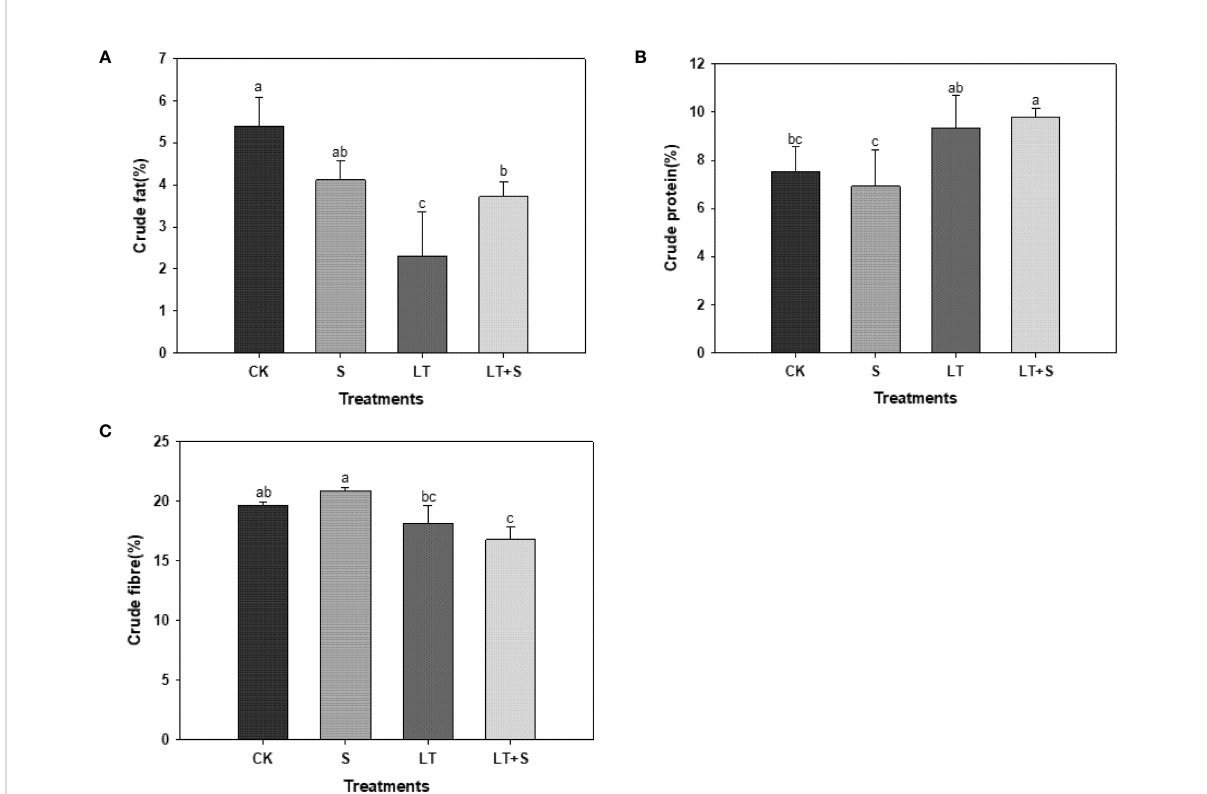
FIGURE 5 The bar chart shows the average of crude fat (A) , crude protein (B) , and crude fi ber (C) content of bermudagrass under each treatment, with three replicates per treatment. Different letters above the same columns indicate statistic signi fi cant difference at P < 0.05 (Ducan ’ s multiple range